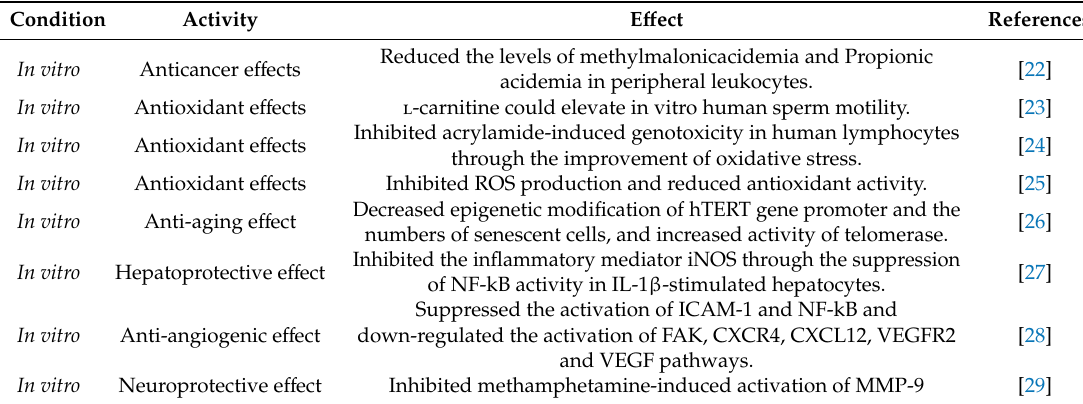
Table 1. An up-to-date picture of in vitro studies of l